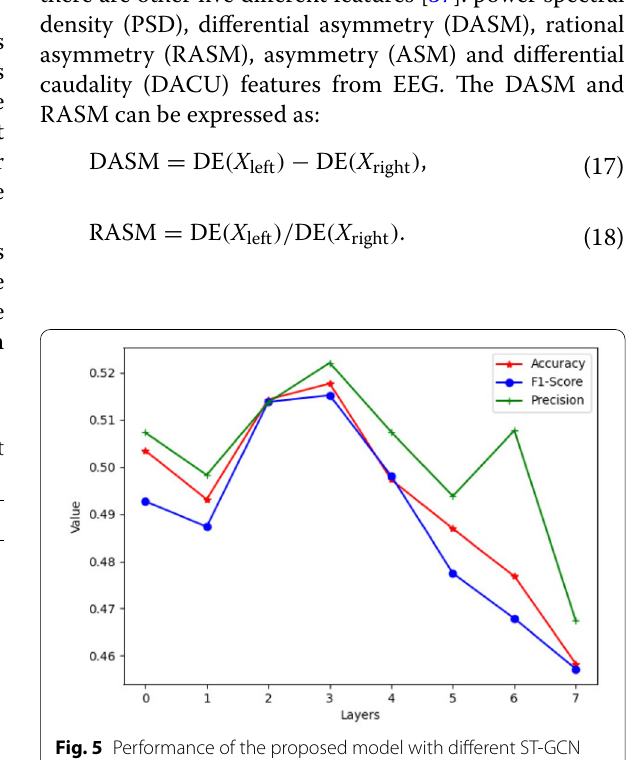
Fig. 5 Performance of the proposed model with different ST-GCN